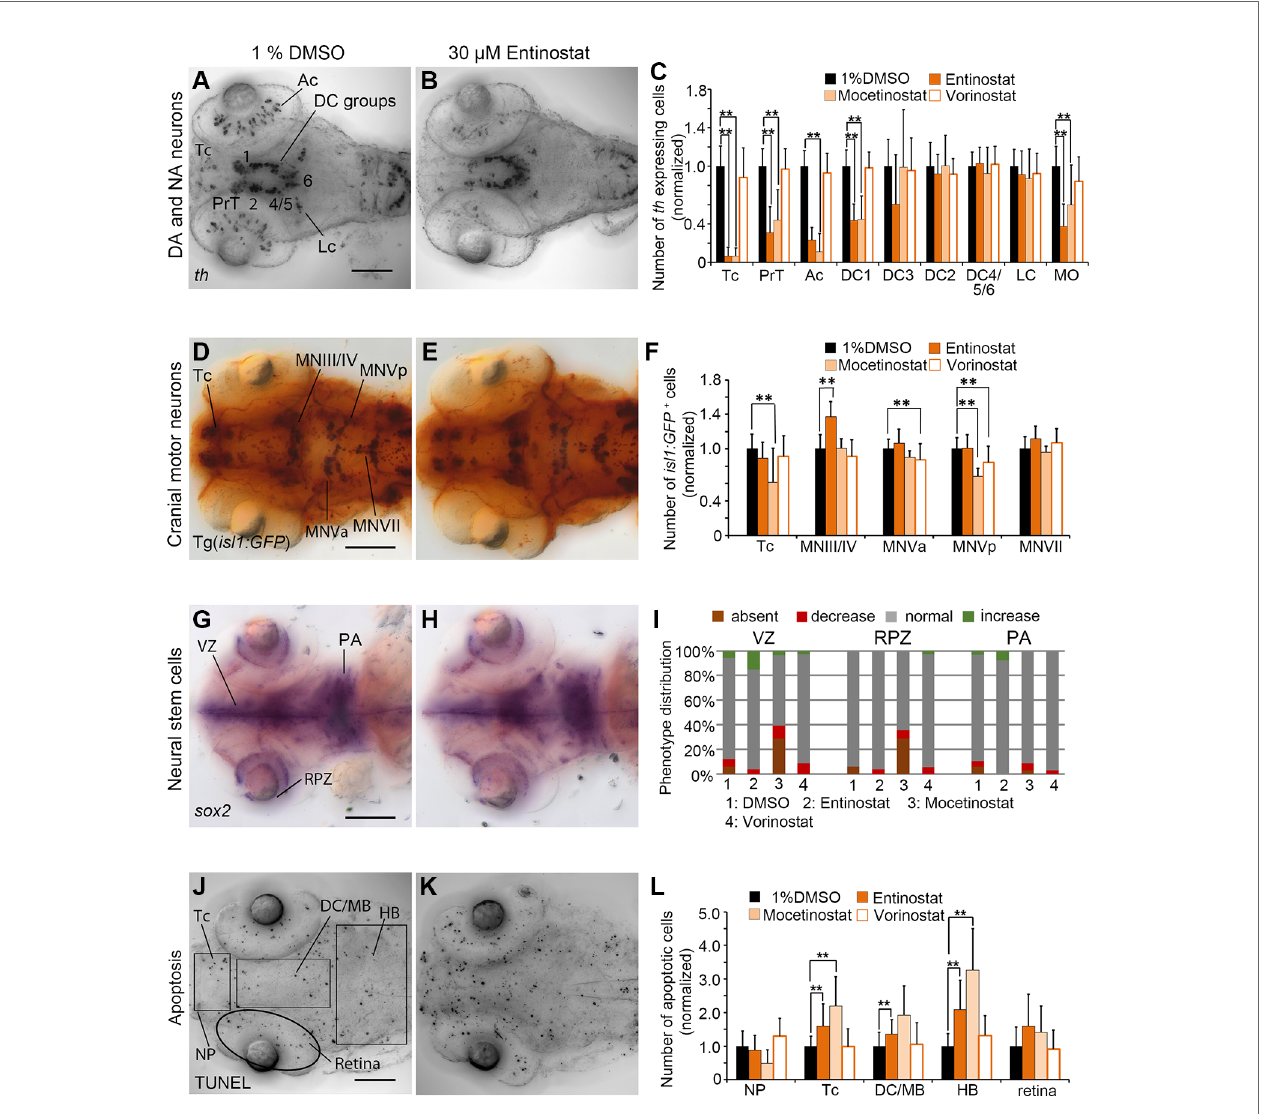
FIGURE 5 | Quanti fi cation of Secondary Screen — HDAC inhibitors. (A – C) Analysis of th expression (WISH) for DA and NA neuron development. (D – F) Immunohistochemistry for Isl1-GFP positive cranial motor neurons. (G – H) WISH analysis of sox2 expression in neural stem cells. (J – L) TUNEL assay to detect apoptotic cells. Embryos were treated with the HDAC inhibitors Entinostat, Mocetinostat or Vorinostatat from 24 to 72 hpf and fi xed at 96 hpf. (A, B, D, E, G, H, J, K) Dorsal views of heads of larvae, images generated from Z-Projections of image stacks, anterior at left. Scale bars represent 100 µm. Bar charts illustrate the mean cell count numbers of each neuronal subtype for (C) th expressing cells, (F) isl1:GFP transgene expressing cells, (L) apoptotic cells. Error bars depict standard deviations of the means. Asterisks indicate signi fi cant differences compared with the 1% DMSO control (p < 0.001). (I) For analysis of sox2 expression, embryos were classi fi ed into absent, decreased, normal or increased sox2 expression phenotypes (see color code) and embryo numbers were normalized to 100%. AC, amacrine cells; DA, dopaminergic; NA, noradrenergic; Tc, telencephalon; PrT, pretectum; DC, diencephalic groups; Lc, locus coeruleus; MO/AP, medulla oblongata/ area postrema; MN, motor neuron cluster; VZ, ventricular zone; RPZ, retinal proliferation zone; PA, pharyngeal arches; NP, nasal placodes; DC/MB, diencephalon and midbrain region; HB,